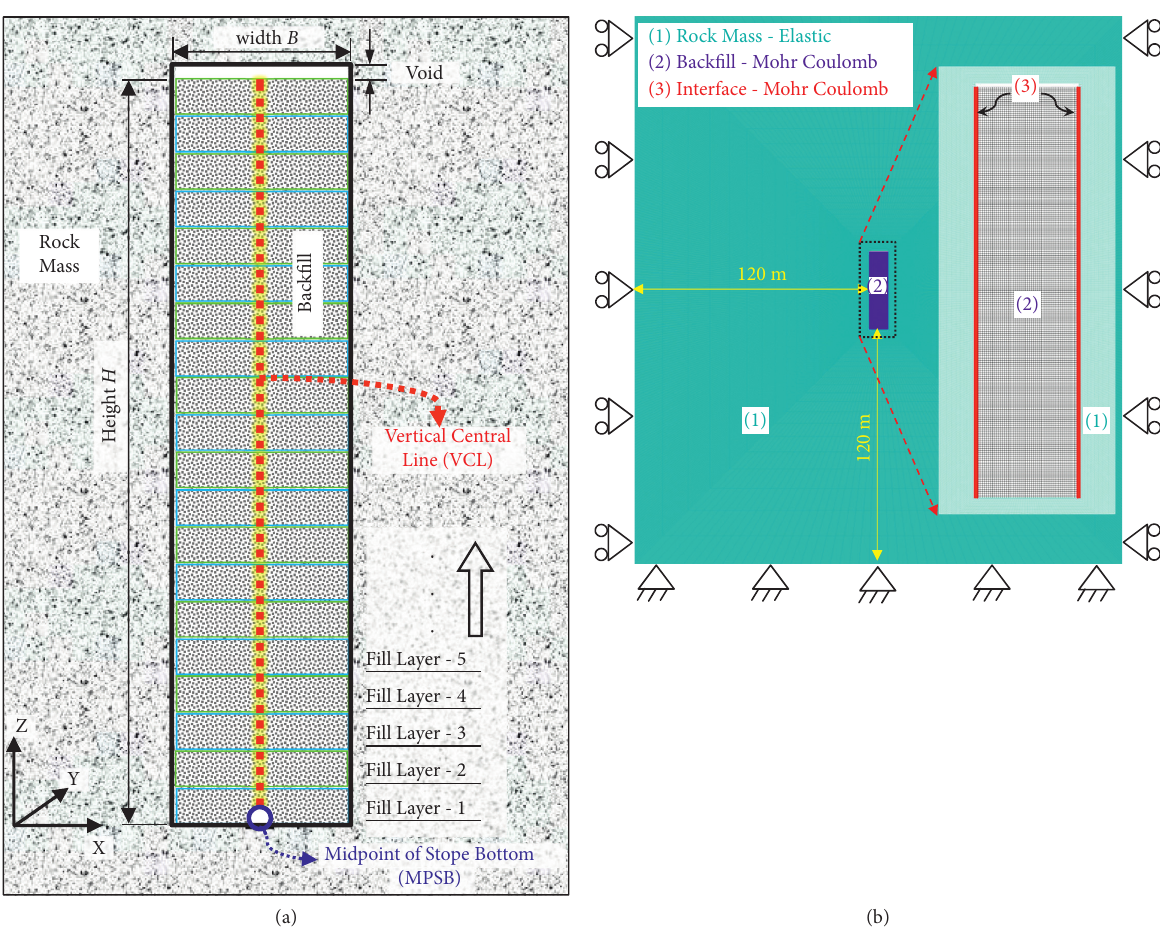
Figure 2: Typical backfilled stope. (a) Physical model. (b) Numerical model built in